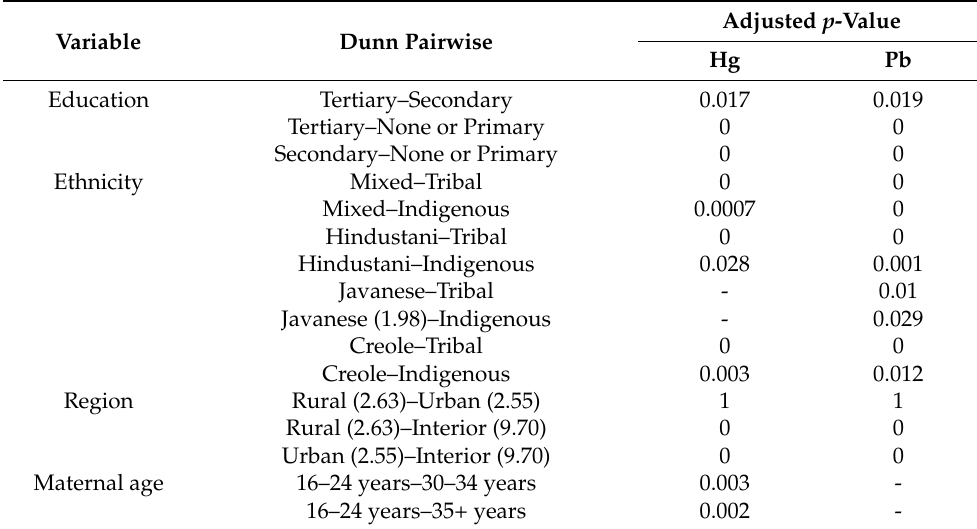
Table 4. Results of examining the relationships between categories within maternal demographic characteristics and exposure to lead and mercury. Median values are reported in Table 1.